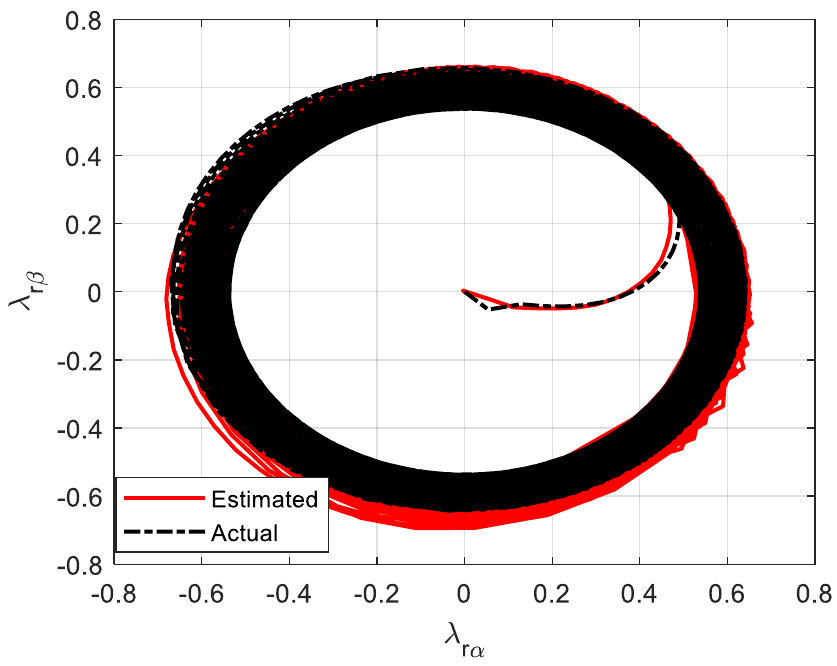
Figure 23. Actual and estimated 𝛼 − 𝛽 rotor flux components considering the case of rotor speed variation.